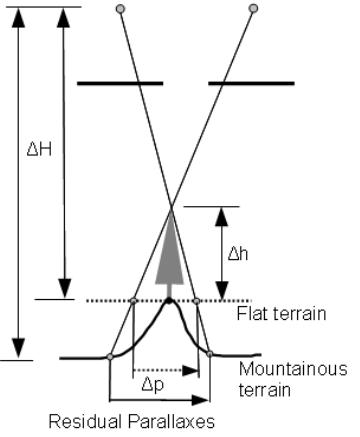
Figure 2. Residual parallax distortion for vertical objects in mountainous